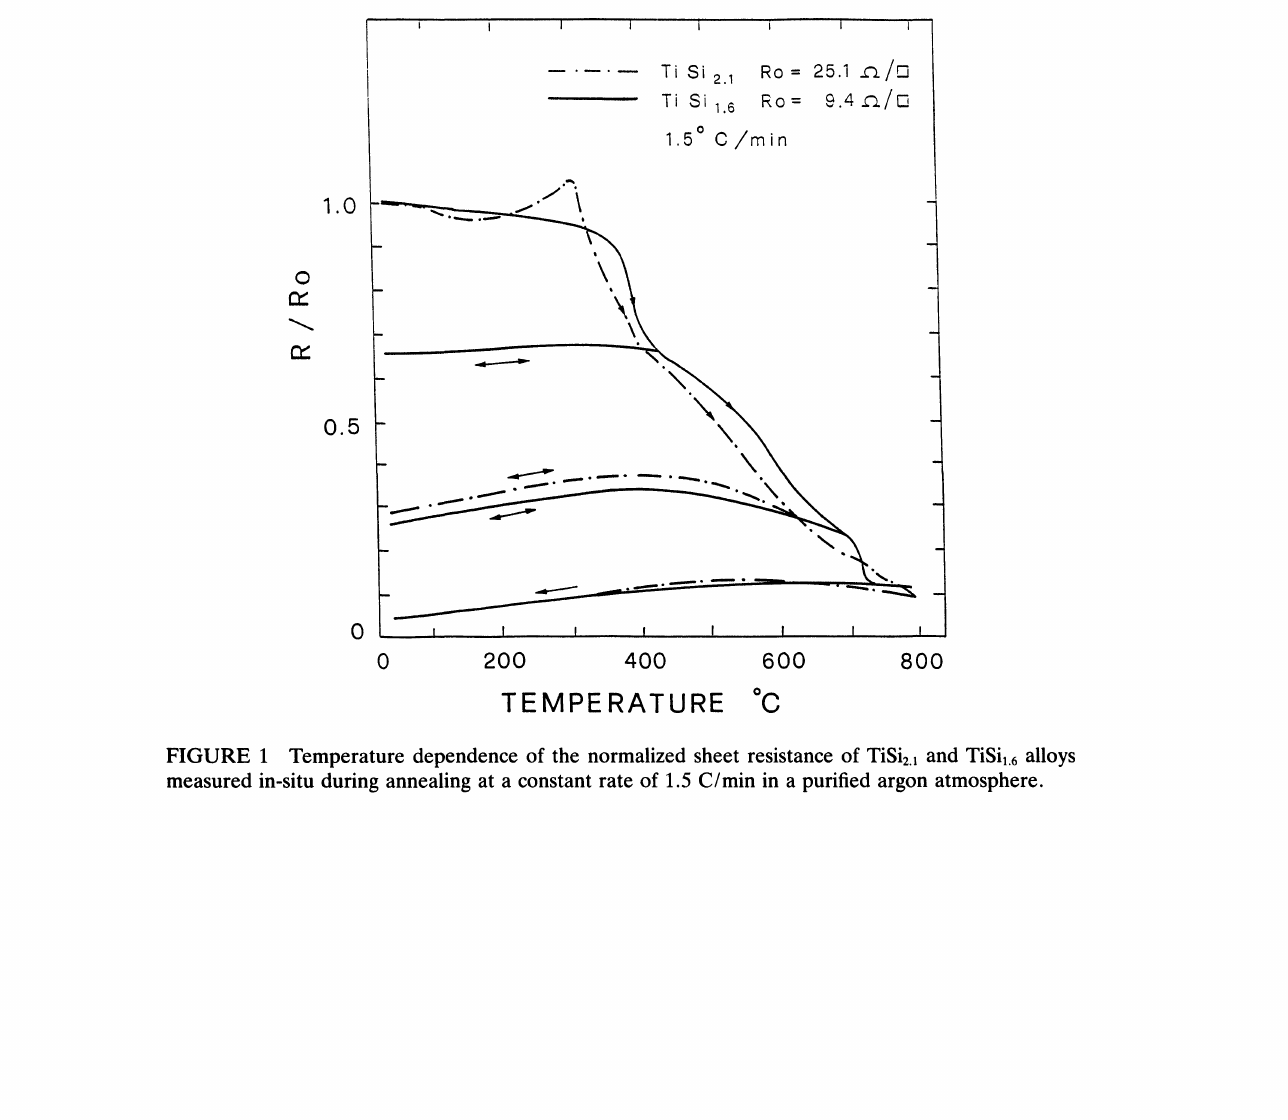
FIGURE Temperature dependence of the normalized sheet resistance of TiSiz. and TiSil.6 alloys measured in-situ during annealing at a constant rate of 1.5 C/min in a purified argon